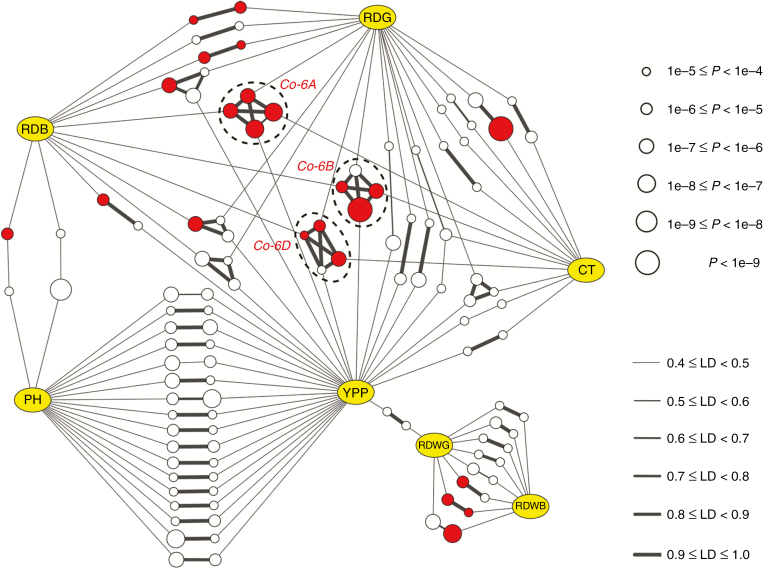
Association networks across different root and shoot traits in wheat. The yellow ellipses represent traits, and the white and red circles represent the SALs responsible, which are detected by GLM and both models, respectively. Only the SALs associated with at least two traits are displayed; the size of the circle indicates the probability of associations. PH, plant height; YPP, yield per plant; CT, canopy temperature; RDB, RDWB: root depth, root dry weight at booting stage; RDG, RDWG: root depth, root dry weight at mid-grain fill stage. The edges between the SALs from different traits are linked by linkage disequilibrium (LD). Only the edges with an average LD ≥ 0.4 are displayed; the thickness of lines indicates the degree of LD. The overlapped SALs (Co-6A, Co-6B and Co-6D) that not only control YPP and CT, but also exhibited stable associations with root depth at different growth periods are highlighted by the dotted black circles.